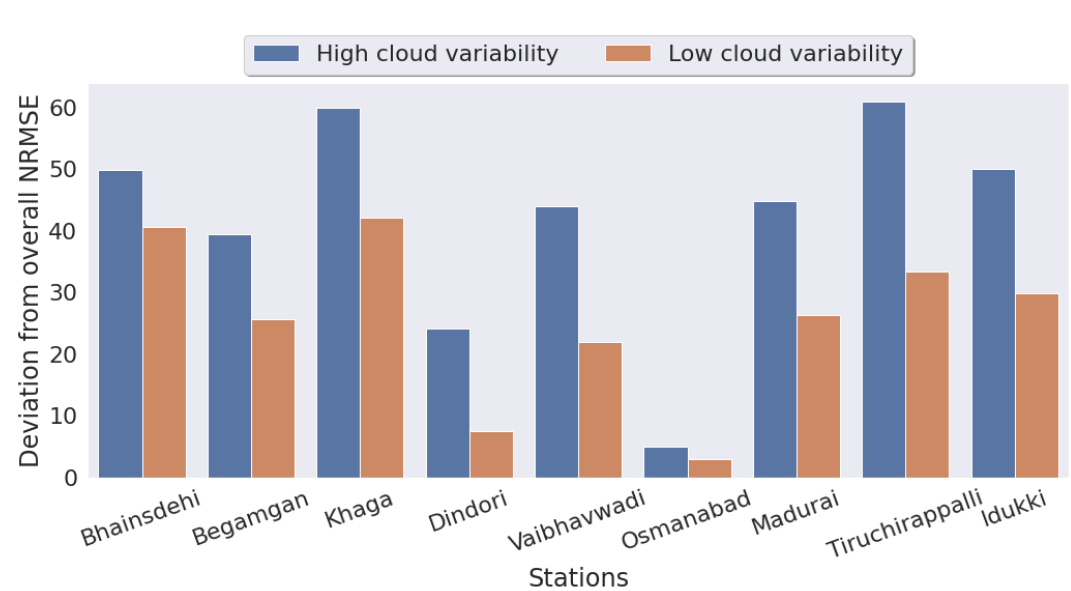
Figure 1. Deviation of NRMSE (%) in high and low cloud-cover variability conditions compared to overall NRMSE